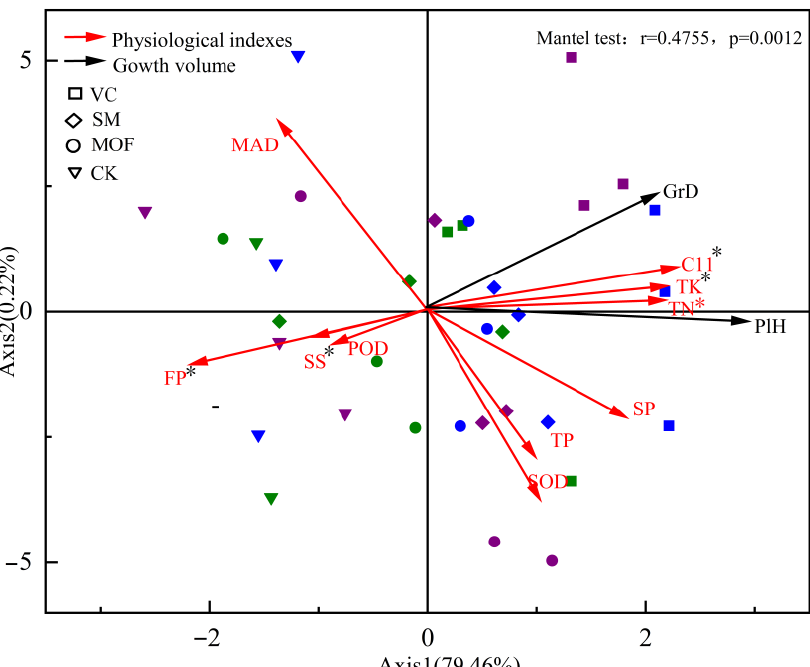
Figure 7. Redundancy analysis of growth and physiological indexes of “Qi-Nan” agarwood seedlings under four kinds of fertilization treatments: No fertilizer (CK); vermicompost (VC); sheep manure(SM); microbial organic fertilizer (MOF); plant height (PlH); stem diameter (GrD); chlorophyll (Chl); available nitrogen (TN); available phosphorus (TP); available potassium (TK); superoxide dismutase (SOD); malondialdehyde (MDA); peroxidase (POD); free proline (FP); soluble protein (SP); soluble sugar (SS). * indicates a significant correlation at p < 0.05 under mental text. Green in the figure represents the measured value of indicators in November 2021; purple represents the measured value of indicators in December 2022; blue represents the measured value of indicators in May 2022.